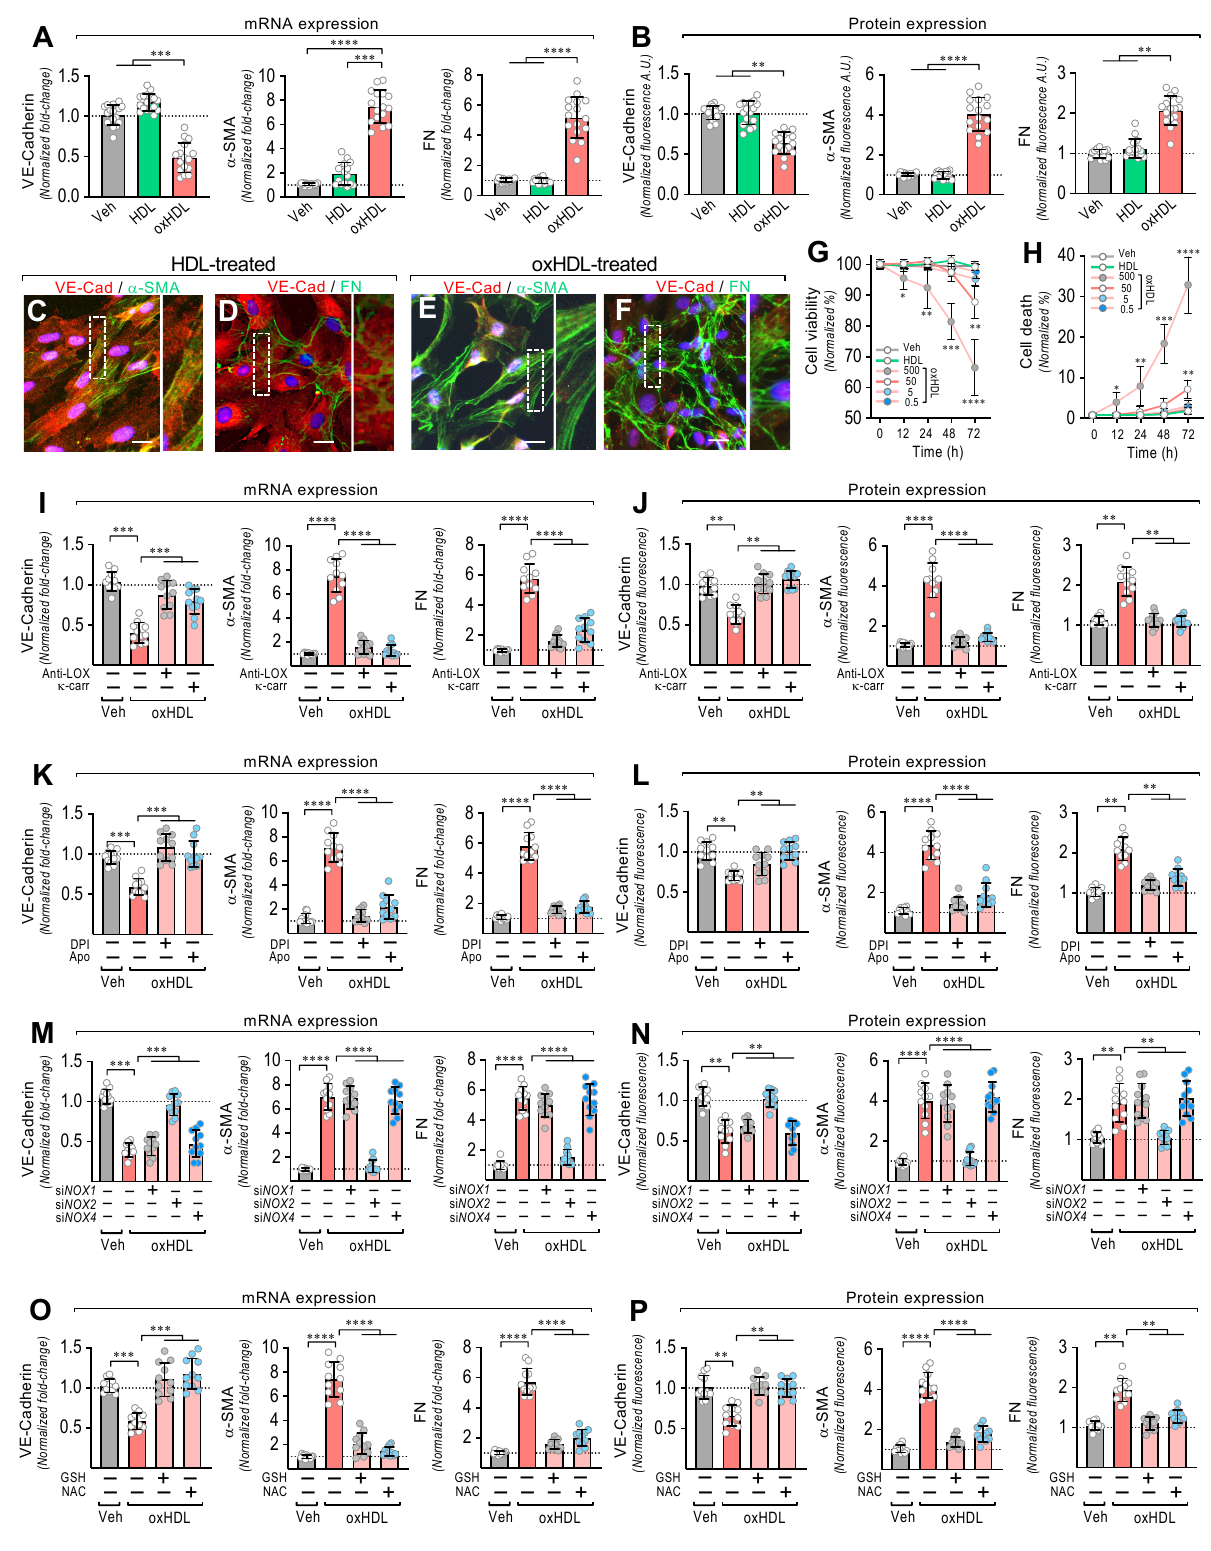
Figure 1. OxHDL induces endothelial fibrosis through the LOX-1/NOX-2/ROS pathway. ( A , B ) ECs were exposed to vehicle, HDL 50 µ g/mL, and oxHDL 50 µ g/mL for 48 h and mRNA ( A ) and the protein ( B ) expression of VE-cadherin (left panels), α -SMA (middle panels), and FN (right panels) was measured. (N = 16). Representative images of cultured ECs treated with HDL 50 µ g/mL ( C , D ) and oxHDL 50 µ g/mL ( E , F ) for 48 h, subjected to fluorescent immunocytochemistry